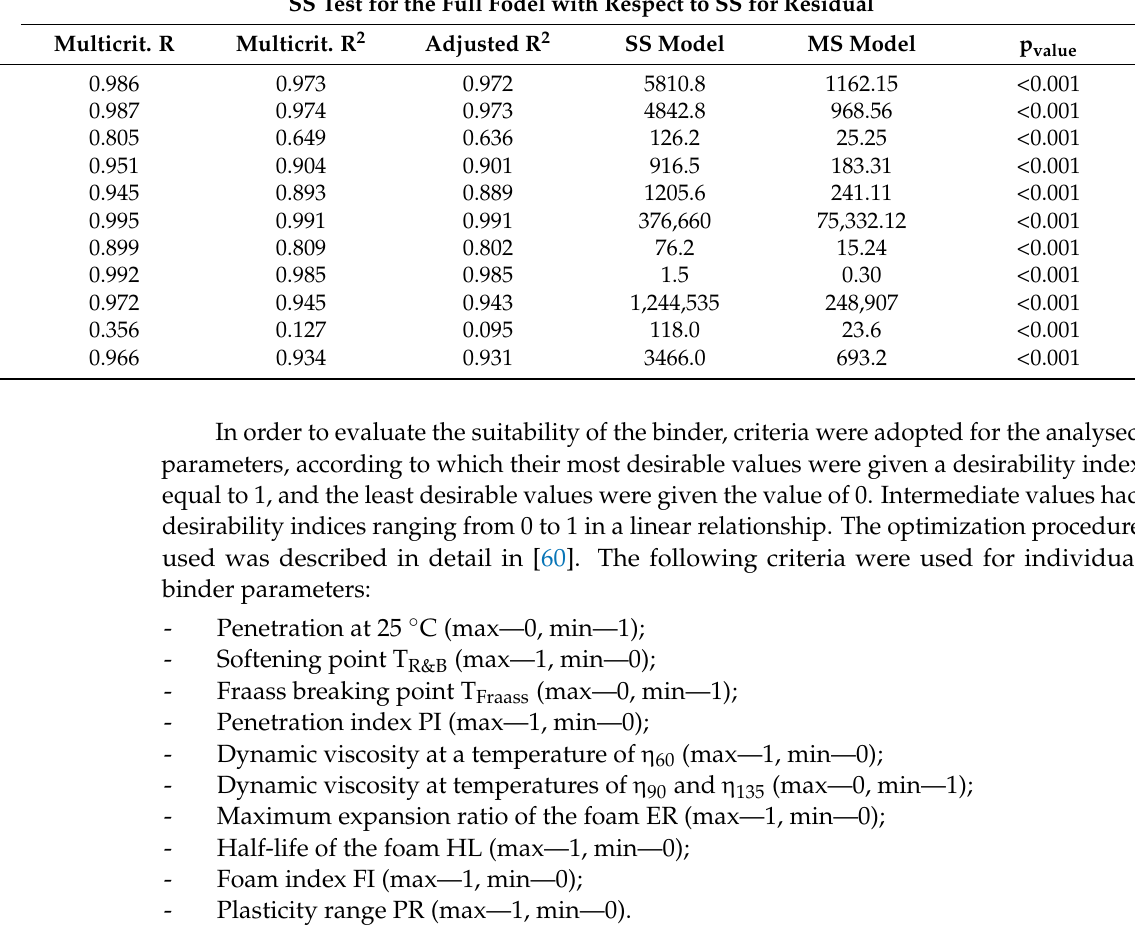
Table 13. Parameters of the models characterizing the variables subjected to optimization. SS Test for the Full Fodel with Respect to SS for Residual Dependent Variable Multicrit. R Multicrit. R 2 Adjusted R 2 SS Model MS